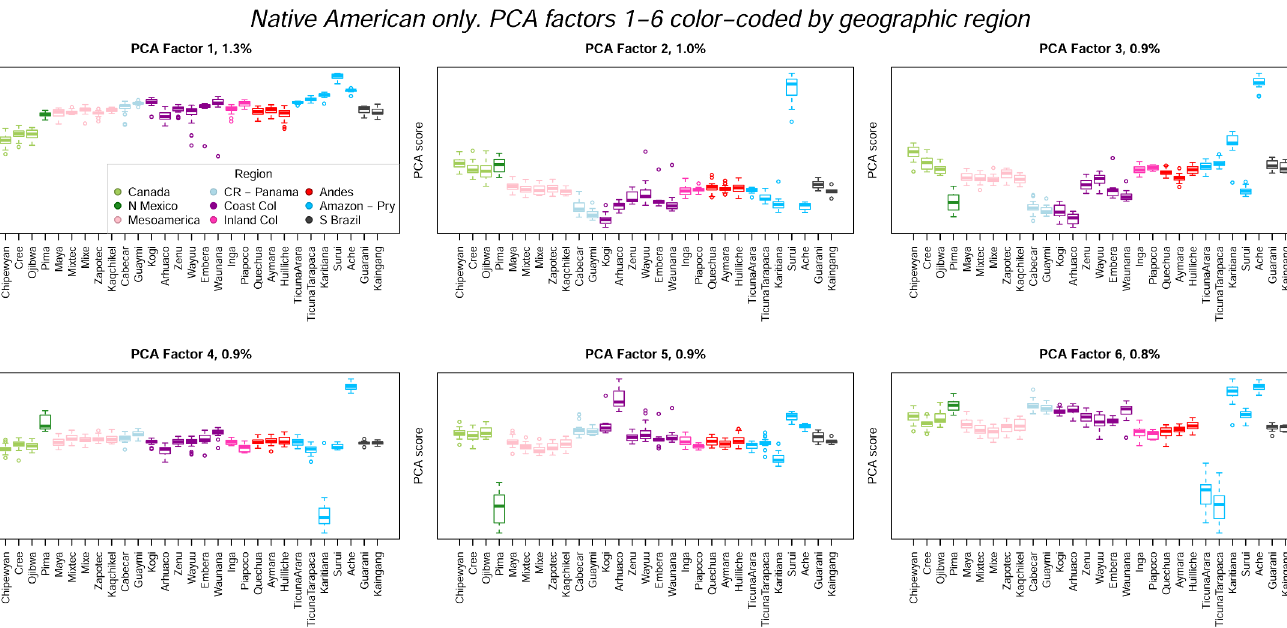
Fig 6. Boxplots of PCAs 1 – 6 for analyses of the Native American populations only, color-coded by geographic